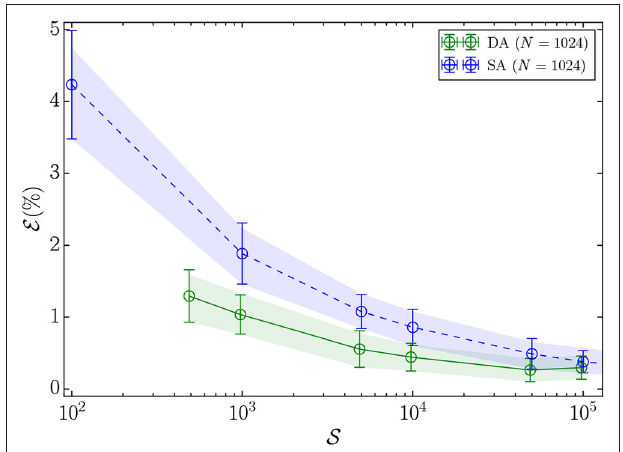
FIGURE 5 | Mean, 5th, and 95th percentiles of the residual energy ( E ) vs. number of Monte Carlo sweeps ( S ) for 2D-Gaussian problem instances with N = 1,024 variables solved by the DA and SA. As the number of Monte Carlo sweeps approaches infinity, the residual energy of both algorithms will eventually reach zero. We have run SA for up to 10 6 sweeps and the DA for up to 10 8 iterations (10 8 / 1024 ∼ 10 5 sweeps). Therefore, the data up to 10 5 sweeps is presented for both algorithms. We expect that by increasing the number of iterations to 10 9 (10 6 sweeps) in the DA, the residual energy would further decrease.